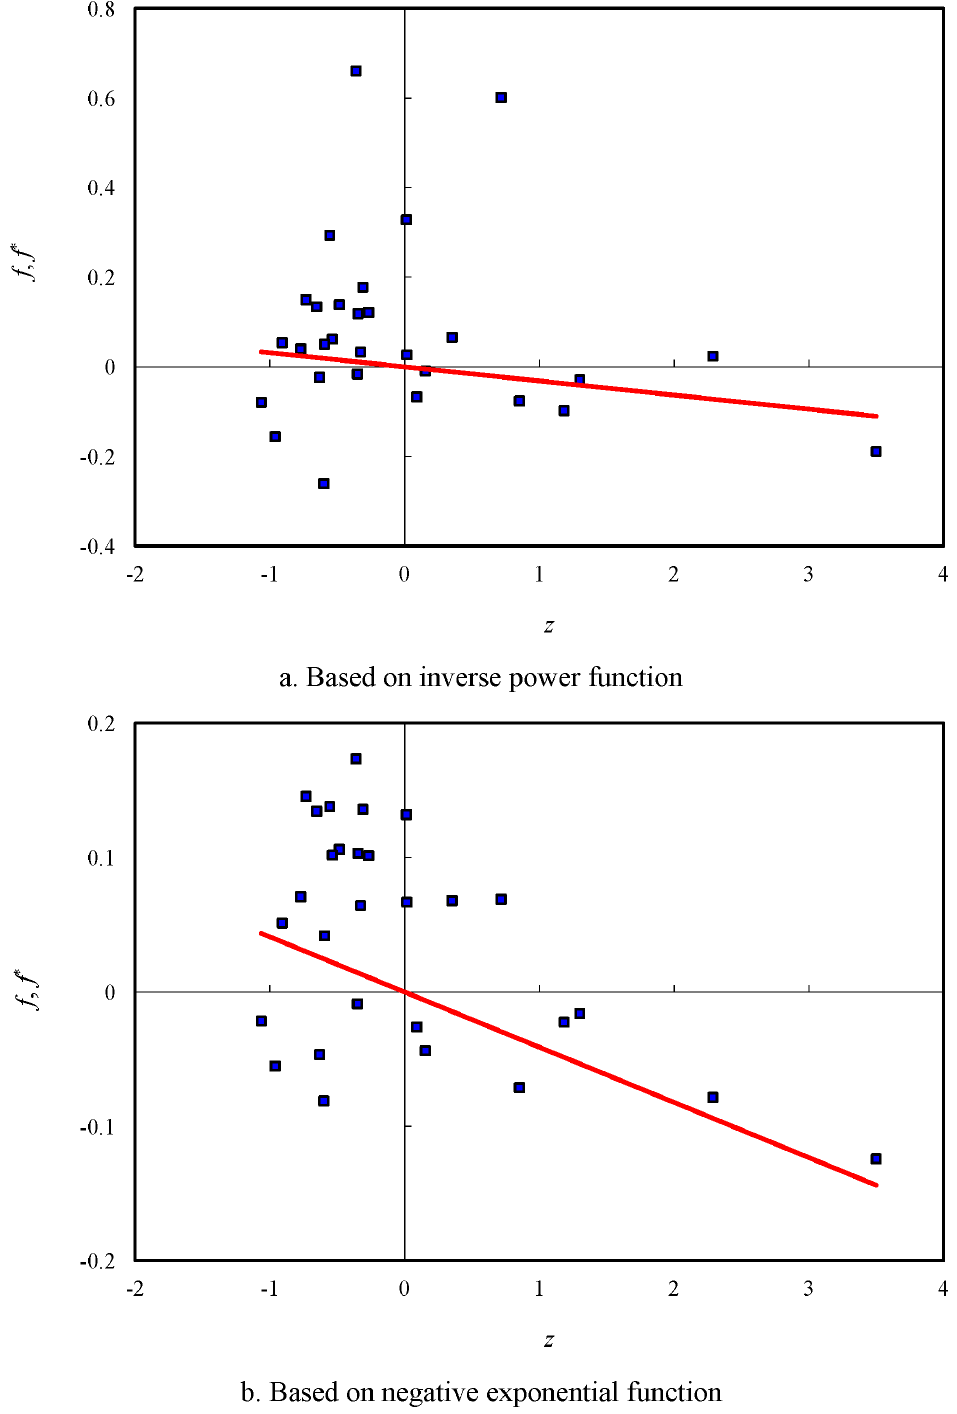
Figure 3. The improved Moran’s scatterplots with trendlines of spatial autocorrelation for the principal cities of China (2000). [a. Based on inverse power function; b. Based on negative exponential function].